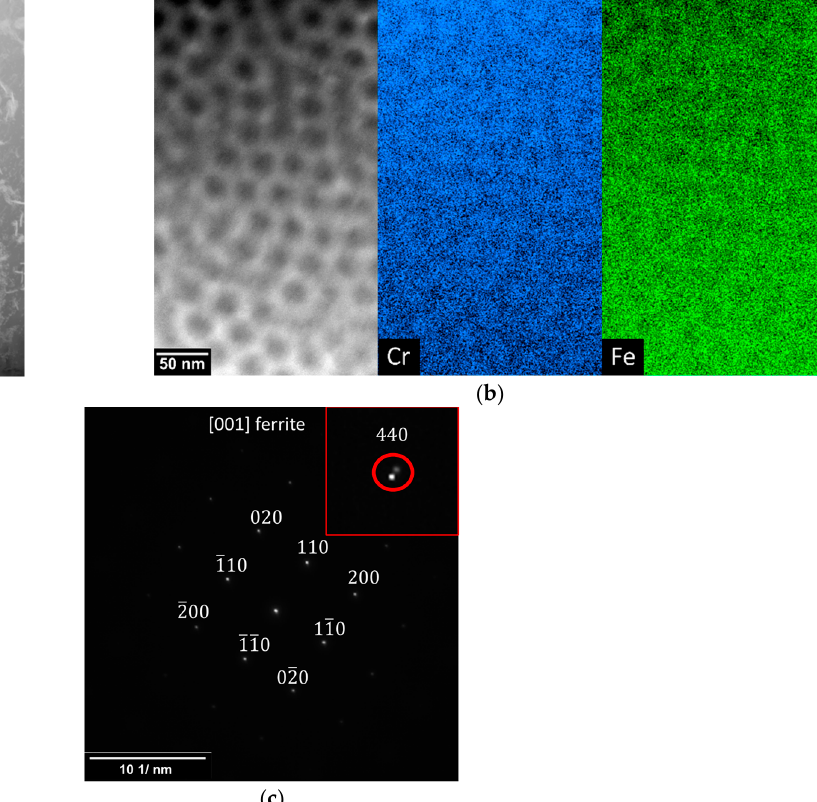
Figure 2. TEM analyses of the ferrite phase of the DSS after heat treatment. ( a ) HAADF-STEM image of a ferritic grain showing Cr 2 N and CrN phases that appear as bright contrast. ( b ) HAADF-STEM image of ferrite and the corresponding EDX mapping of the elements Fe and Cr, ( c ) SAD pattern taken close to the [001] zone axis. The inset indicates the splitting of the diffraction spot [440] due to spinodal decomposition.